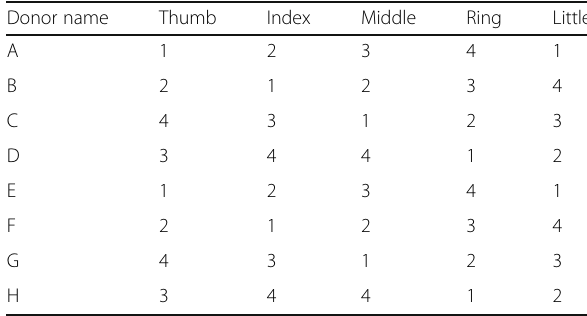
Table 5 Sample classification method using different treatment